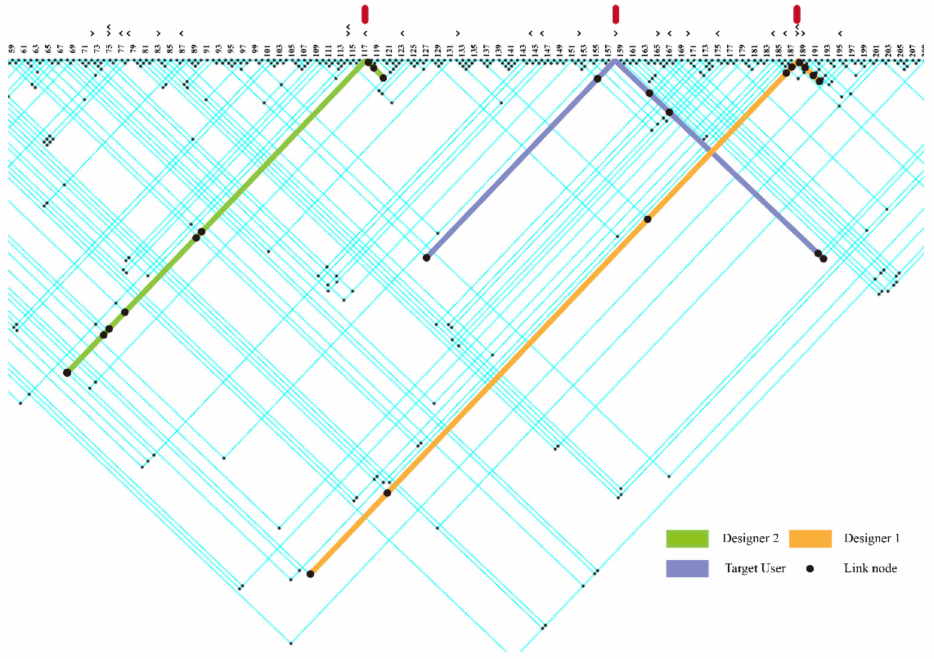
Figure 3. Link nodes included in <117, 158> and